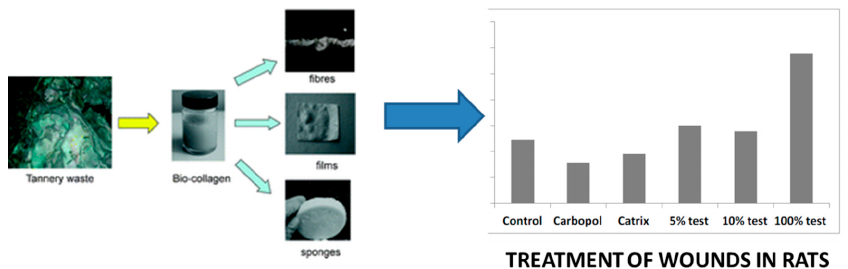
Figure 4. From slaughterhouse/tannery waste to biocollagenic polymers with applications in tissue regeneration. Reproduced by Permission of the Royal Society of Chemistry from reference [23].